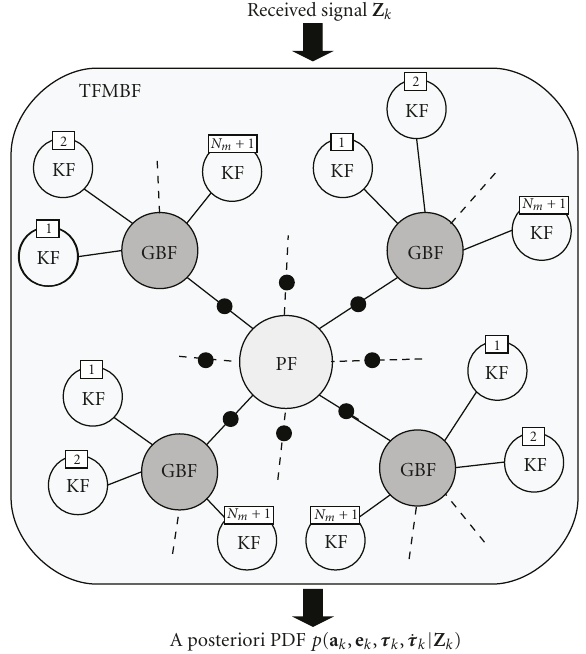
Figure 1: Structure of the two-fold marginalized filter, which infers the a posteriori PDF of the channel parameters from the blockwise processed received signal. Each particle (black dots) of the central particle filter (PF) carries a grid-based filter (GBF) in which there are several Kalman filters (KF) according to the combination of active paths. The number of complex amplitudes to be tracked per KF (as indicated by the numbers in the boxes) ranges from 1 to N m + 1.